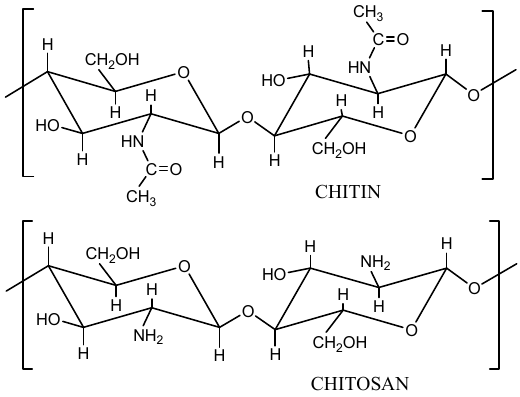
Figure 1. Structure of chitin and chitosan unit [20].